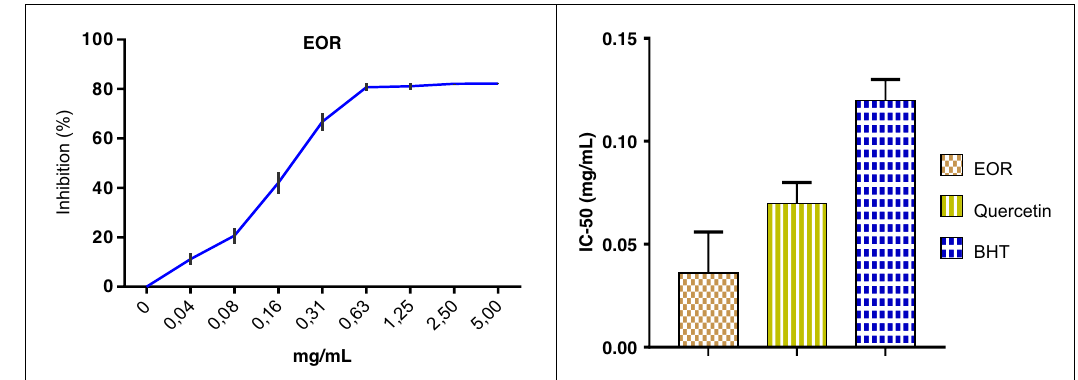
Figure 3: Antioxidant activity by the DPPH assay for EOR along with controls ( BHT and Quercetin ) .